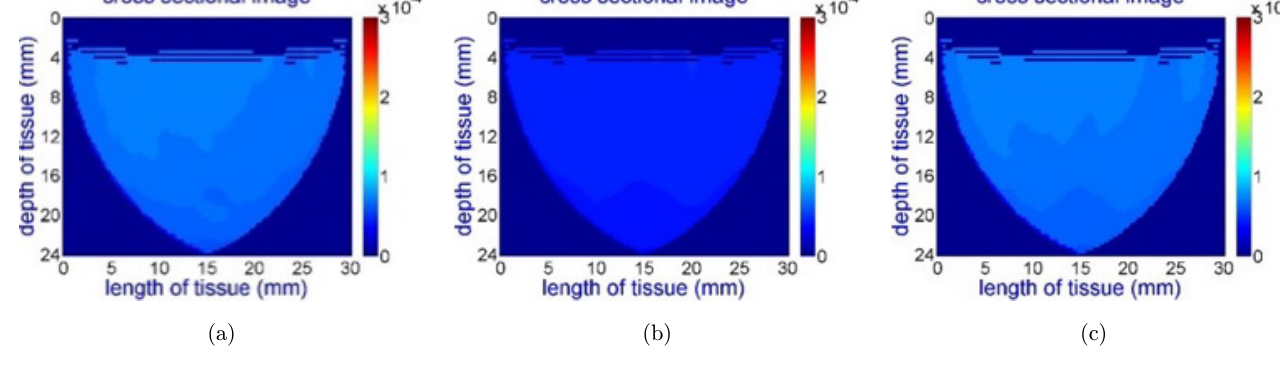
Fig. 8. Reconstructed cross-sectional images of the RBSA phantom for the wavelength of 800 nm while the center line of the probe is aligned: (a) with the center of the hole, (b) 7 mm left to the hole, (c) 7 mm right to the hole for 750 nm, 800 nm and 850 nm light